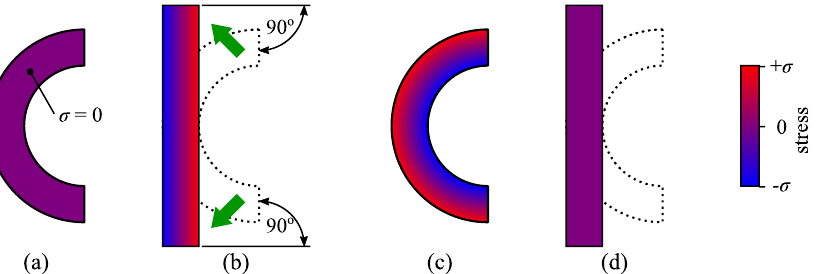
Figure 6. Procedure to determine and apply the residual stresses in the initially bent regions: ( a ) bent belt, ( b ) straightened belt and resulting stress distribution, ( c ) bent belt with applied residual stresses, and ( d ) approximately stress-free belt after straightening.